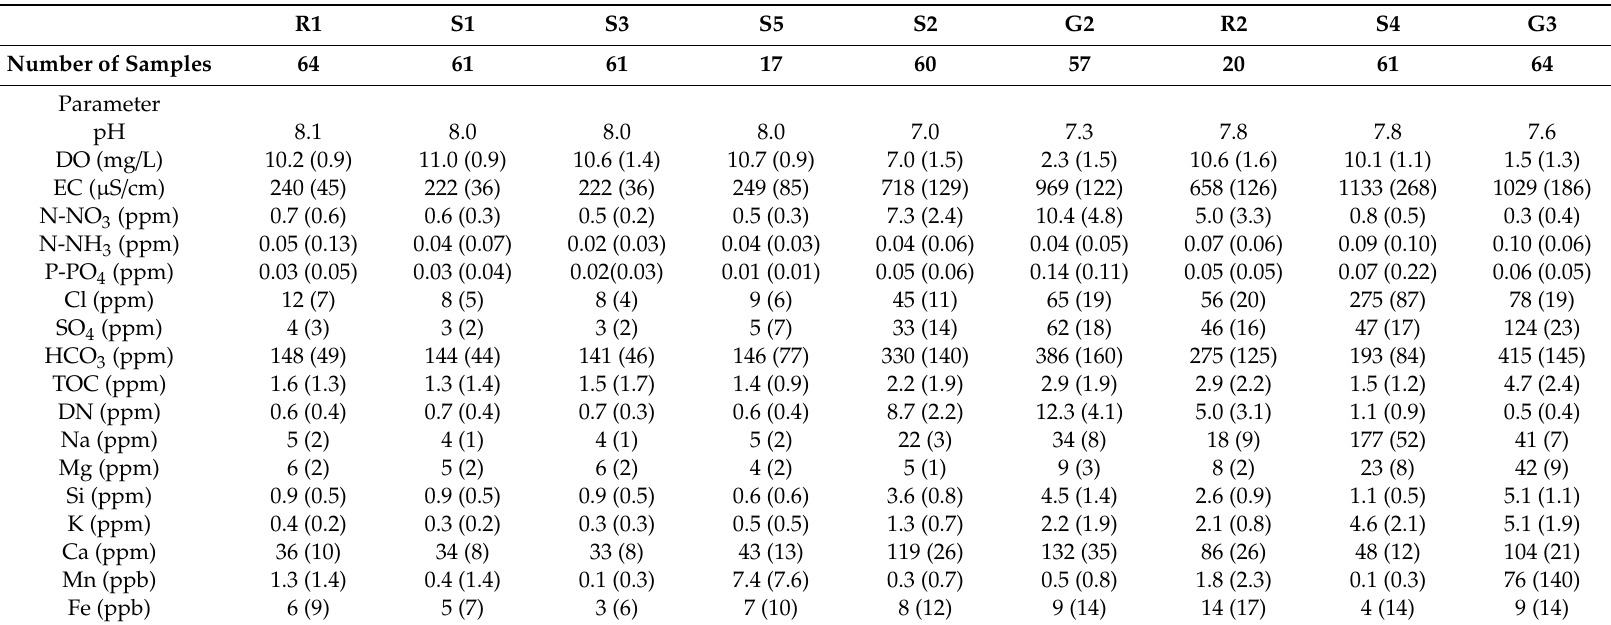
Table 4. Average chemical characteristics for the 9 sampling locations. Parentheses show standard